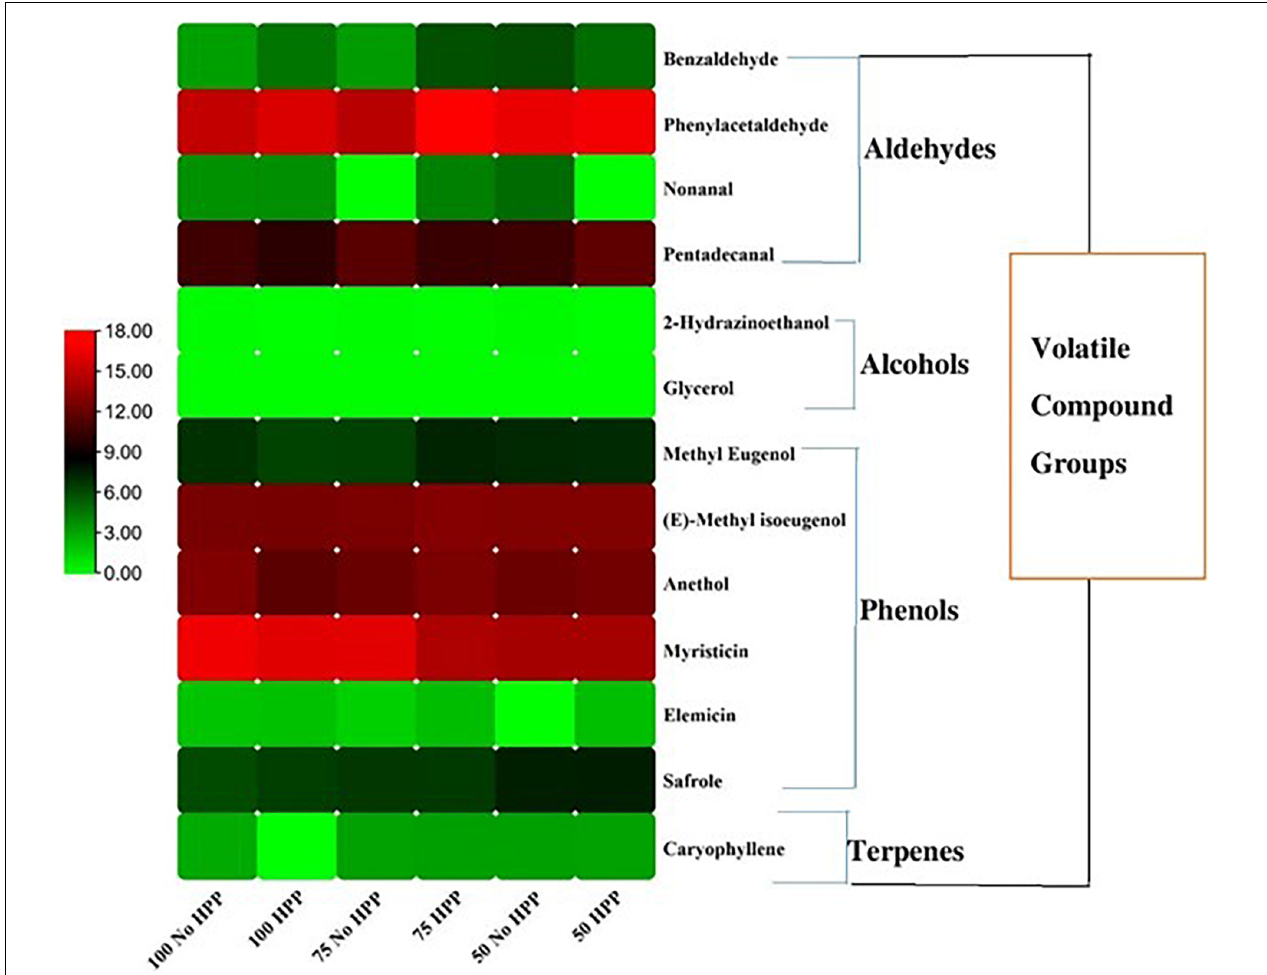
FIGURE 7 | Heat map of odor activity values (OAVs) of volatile compounds in sausage stored at 14 days. The color scale indicates the intensity of the OAV.